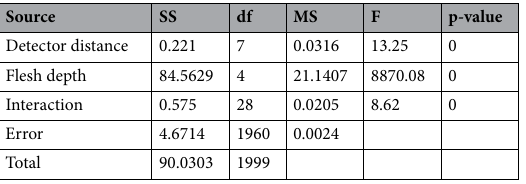
Table 2. Two-way ANOVA results of main and interactive effects of SDS distance and flesh depth on model prediction accuracy.